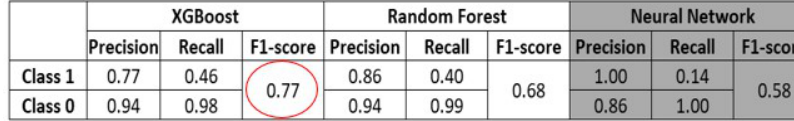
Figure 12. Comparison of NN results through different metrics.